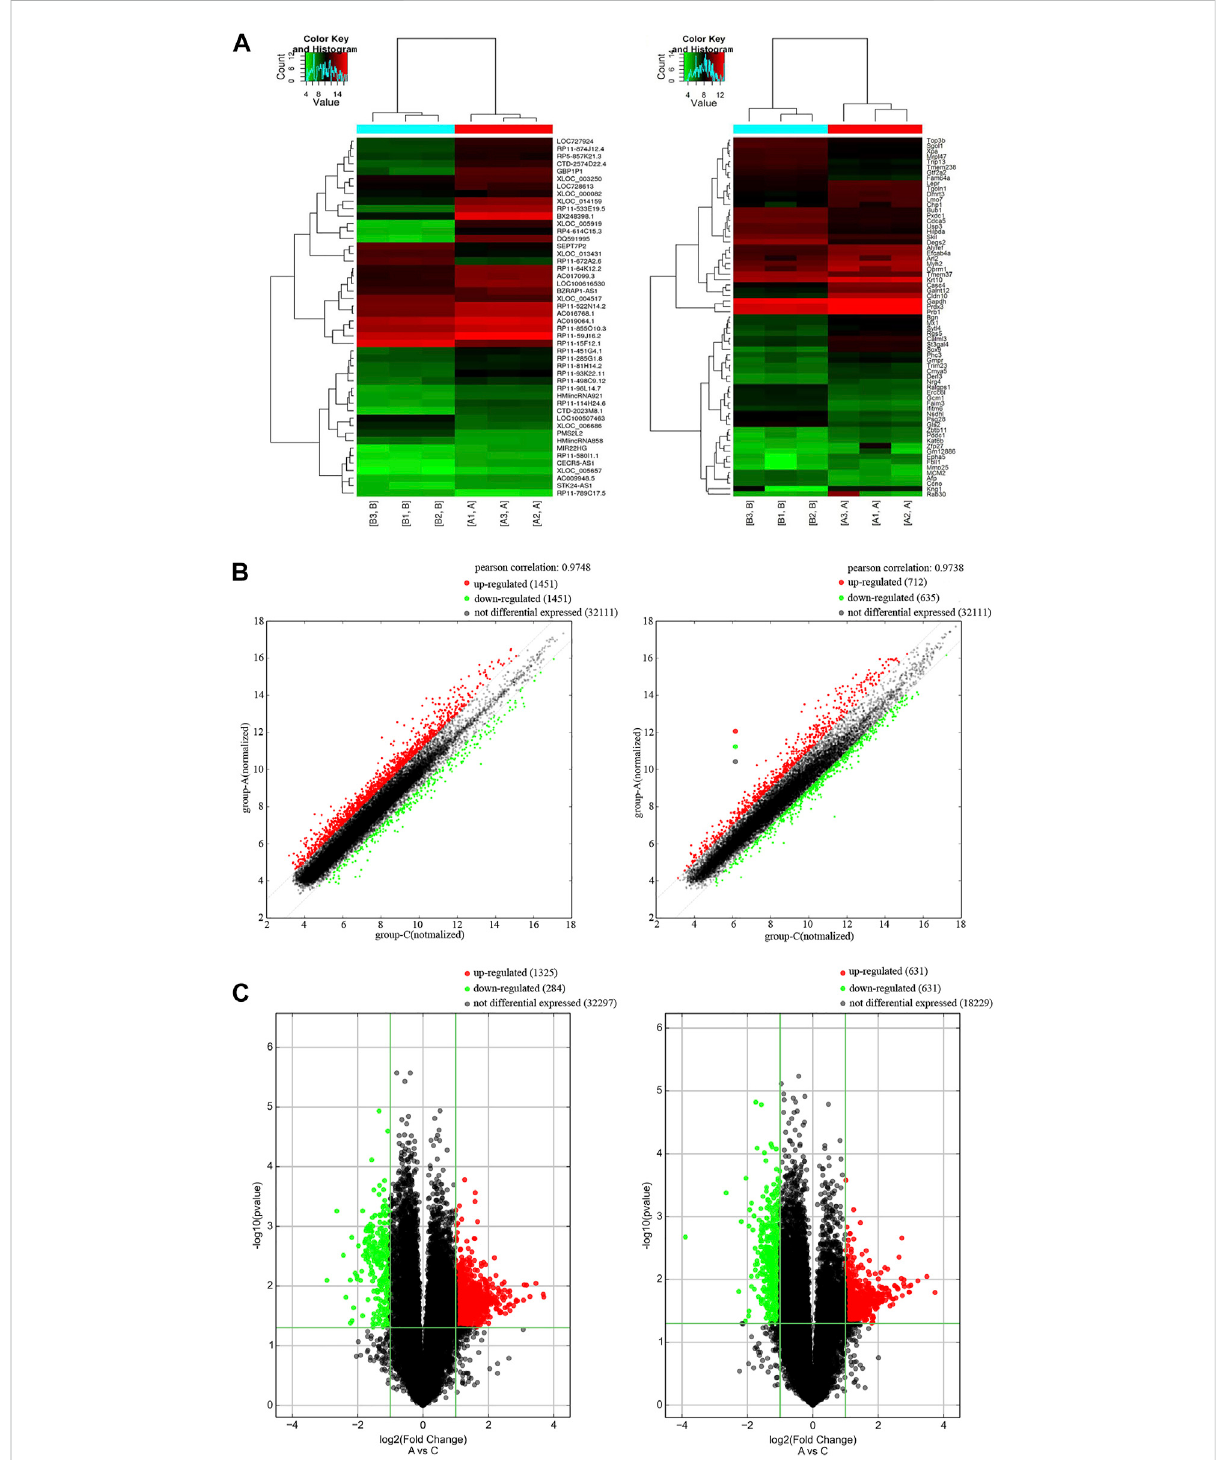
Differentially expressionoflncRNAs andmRNAs inAD patients. (A) Cluster heat mapoftheexpression pro fi les oflncRNAs andmRNAs between 3pairsofAD patients andcontrols.Red represents up-regulated genesand green represents down-regulatedgenes. (B) Scatterplotof lncRNAs and mRNAsinADandcontrol.Redrepresentsup-regulatedgenesandgreenrepresentsdown-regulatedgenes. (C) VolcanoplotofmRNAandlncRNAin AD and control. X-axis parallel line: p = 0.05; Y-axis parallel line:FC value= 2. Red area, p < 0.05, FC ≥ 2 differentialgenes;Green area, p < 0.05, FC ≤ 0.5 differential